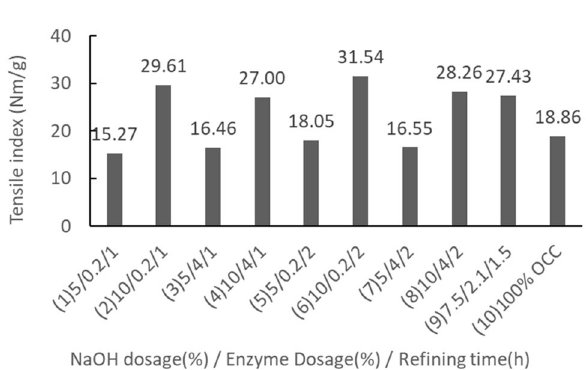
Figure 7. The effects of rice straw semi-chemical mechanical pulp experimental sets with respect to their handsheet tensile